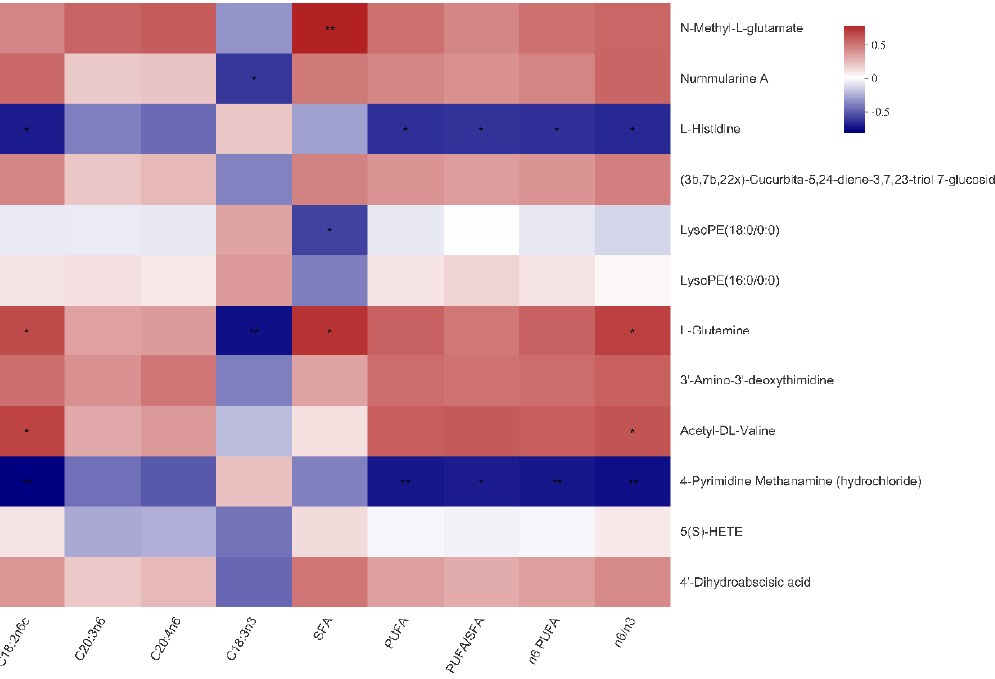
Figure 5. Correlations between serum metabolites and fatty acid composition in the soleus muscle of the Bama Xiang mini-pigs. The top 50 metabolites were selected. Levels of significance are defined as * p < 0.05 and ** p < 0.01.